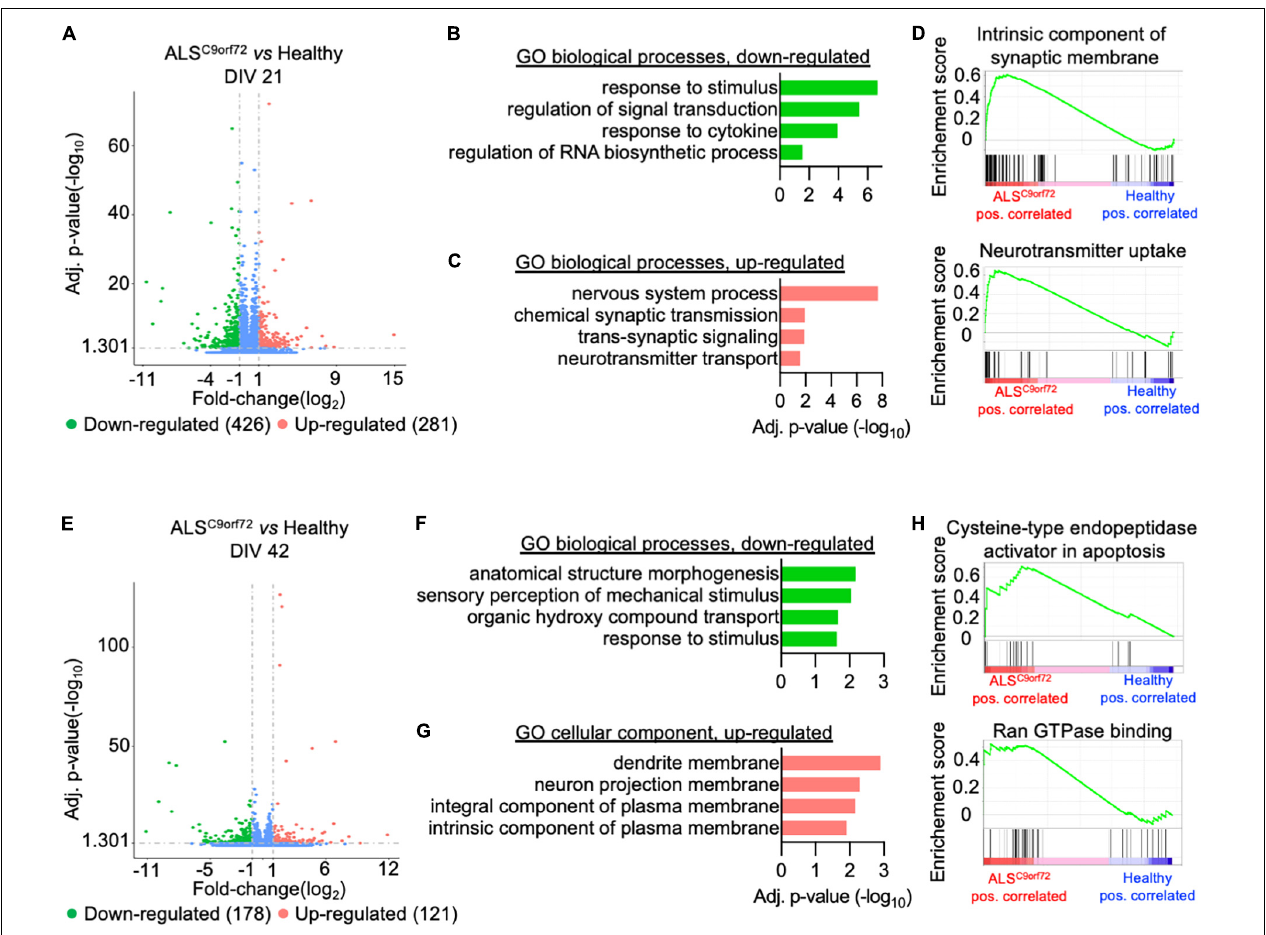
FIGURE 3 | Activity alterations of ALS C9orf72 motor neurons are recapitulated by their transcriptional programs. (A) Volcano plot displaying the down- and up-regulated DEGs in ALS C9orf72 MN at DIV21. (B) Representative GO biological pathways significantly down- or (C) up-regulated in mutant cultures. (D) GSEA confirming the increased expression of transcripts involved in neuronal firing. (E) Volcano plot displaying the down- and up-regulated DEGs in ALS C9orf72 MN at DIV42. (F) Representative GO biological pathways significantly down-regulated in mutant cultures. (G) GO cellular component terms significantly up-regulated in ALS C9orf72 . (H) GSEA showing increased expression of transcripts involved apoptosis and Ran GTPase binding in aged mutant